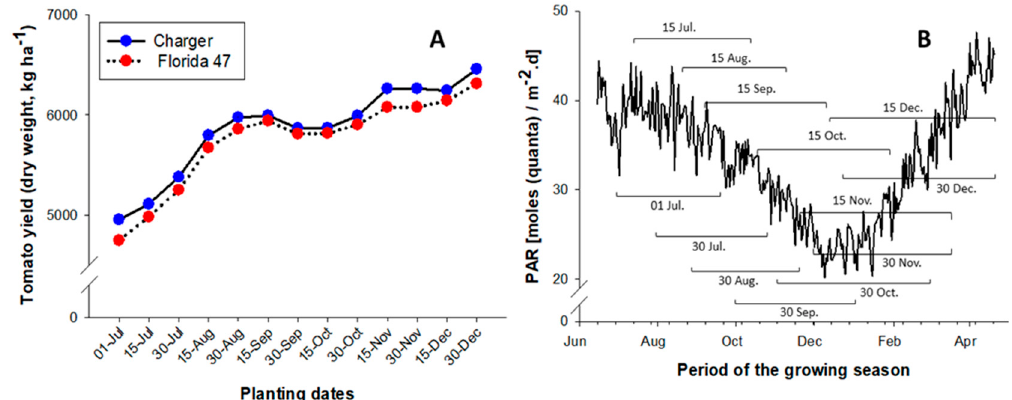
Figure 7. Effects of planting dates on drip irrigated fresh market tomato yield ( A ) and photosynthetic active radiation [PAR, ( B )] collected from Florida Automated Weather Network during the growing seasons at different planting dates in Immokalee Florida.